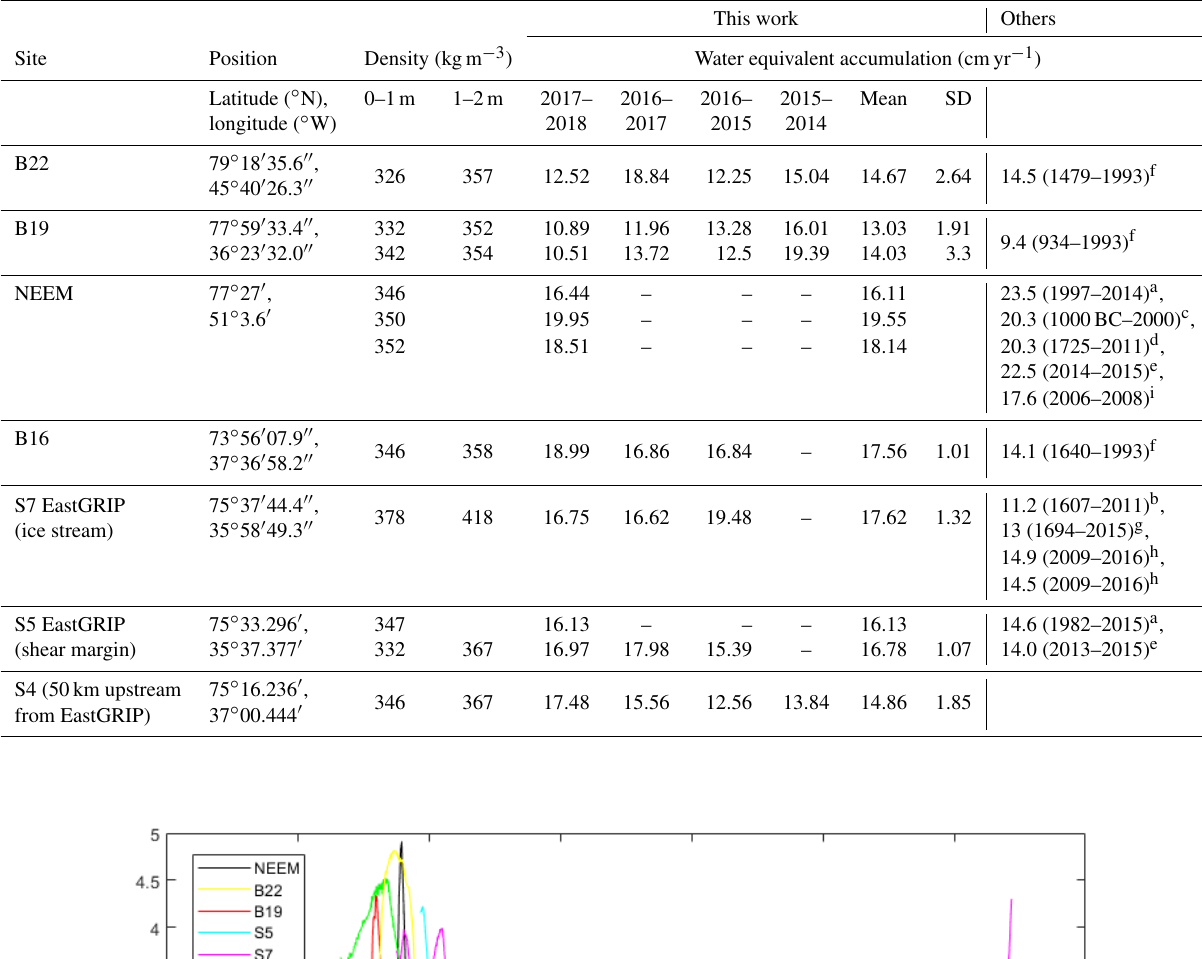
Table 1. Accumulation as determined by the summer hydrogen peroxide peak measured using the LISA box for several sites in northern Greenland. Densities are estimated based on 1m snow core weights. Accumulation from other sources and the time period covered by these sources (in parentheses) are also shown. The studies referenced in the table are as follows: Kjær et al. (2021) a , Vallelonga et al. (2014) b , Rasmussen et al. (2013) c , Masson-Delmotte (2015) d , Schaller et al.(2016) e , Weißbach et al. (2016) f , Karlsson et al.(2020) g , Nakazawa et al. (2020) h and Kuramoto et al. (2011) i .